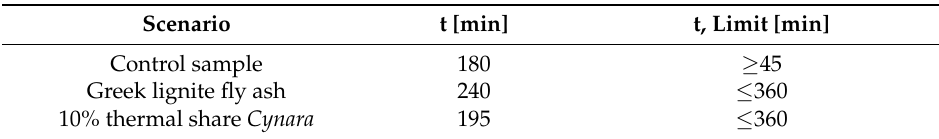
Table 9. Initial setting time results for some fly